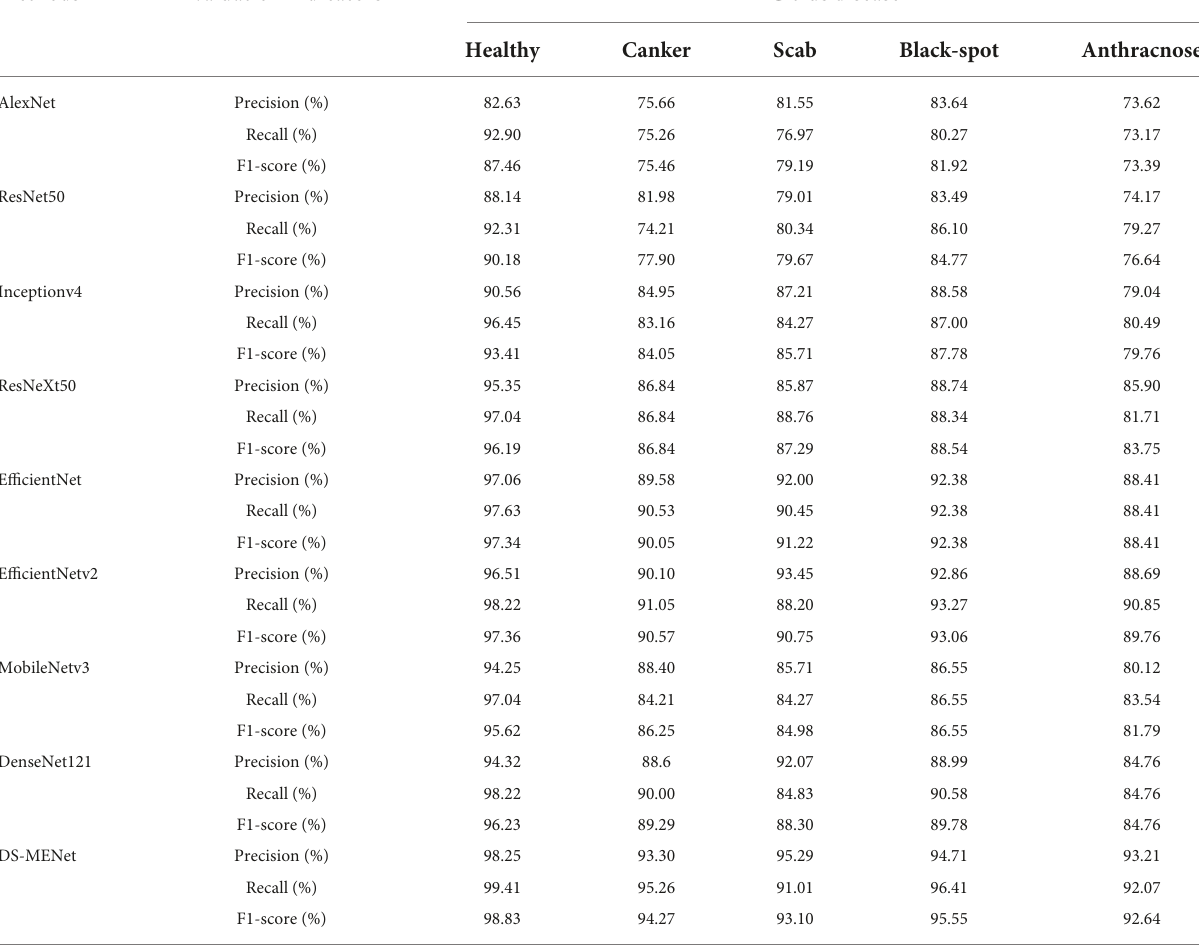
TABLE 6 Evaluation of classification performance of DS-MENet and other networks.